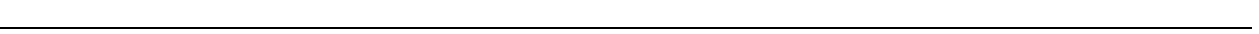
Fig. 2 Effect of LIMB implantation on bone tissue, general health, and activity of the mice. a Picture of an explanted femur including the LIMB implant shows the fi xation plate bridging between the angle-stable screws, thereby preventing direct contact to the bone surface/periosteum. Scale bar = 2 mm. b 3D reconstructed µ CT images of a femur bearing the LIMB implant con fi rm no direct contact between bone and fi xation plate. Shadows below the positioner are beam hardening artifacts of the high attenuation titanium alloy. c 3D reconstructed µ CT images of an intact femur (lower panel) and a femur after removal of the LIMB implant (upper panel). Bone surface under the fi xation plate 7 days after implantation appears similar to the bone surface of the intact femur. Bone growth is observed only around the bicortical screws. d Total bone volume (upper panel) and BV/BS (lower panel) of LIMB and contralateral femur, respectively ( n = 4 mice). e Longitudinal cross-section through a µ CT reconstruction of a femur after implant removal (left panel). Yellow lines represent the positions chosen to measure the bone thickness. For each position, the intensity pro fi le was approximated with two Gaussian curves as indicated in the left graph. f 3D reconstruction of µ CT data showing the planes of transverse cross-sections displayed in the lower two panels. At day 21 after implantation, calci fi ed bone forms around the bicortical screws, but not around the endoscope tubing. Cross-section µ CT images at the sites of the screws show enough space for the bone marrow tissue to connect the diaphysis with the metaphysis. g No differences in bone thickness between contralateral and LIMB femurs are measured ( n = 5 mice). h Total clinical score over 3 weeks post-surgery based on behavior and appearance of the individual mice ( n = 79 mice). i Physical activity of LIMB implanted mice, pre-surgery and post-surgery, and of co-housed control mice. The LIMB- implanted mice reach their pre-surgical activity level within the same time as sham-treated controls (right graph) (two independent experiments; n =